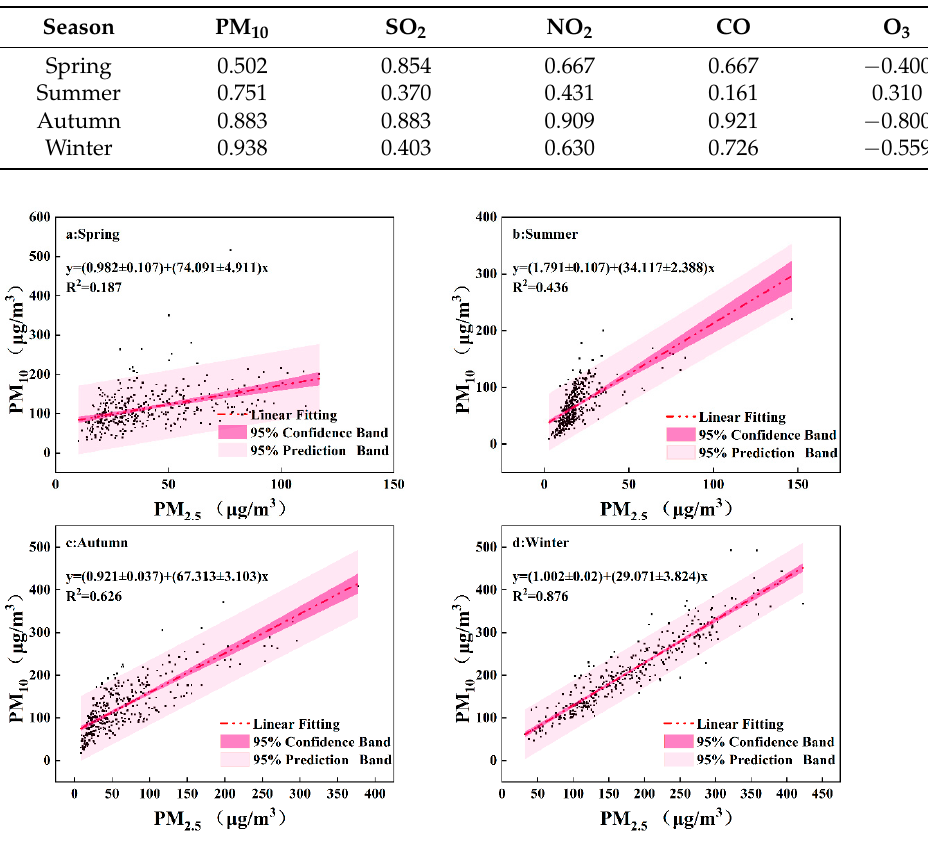
Figure 11. Quasi-linear relationships between PM 2.5 and PM 10 in four different seasons. ( a : Spring; b : Summer; c : Autumn; d : Winter).